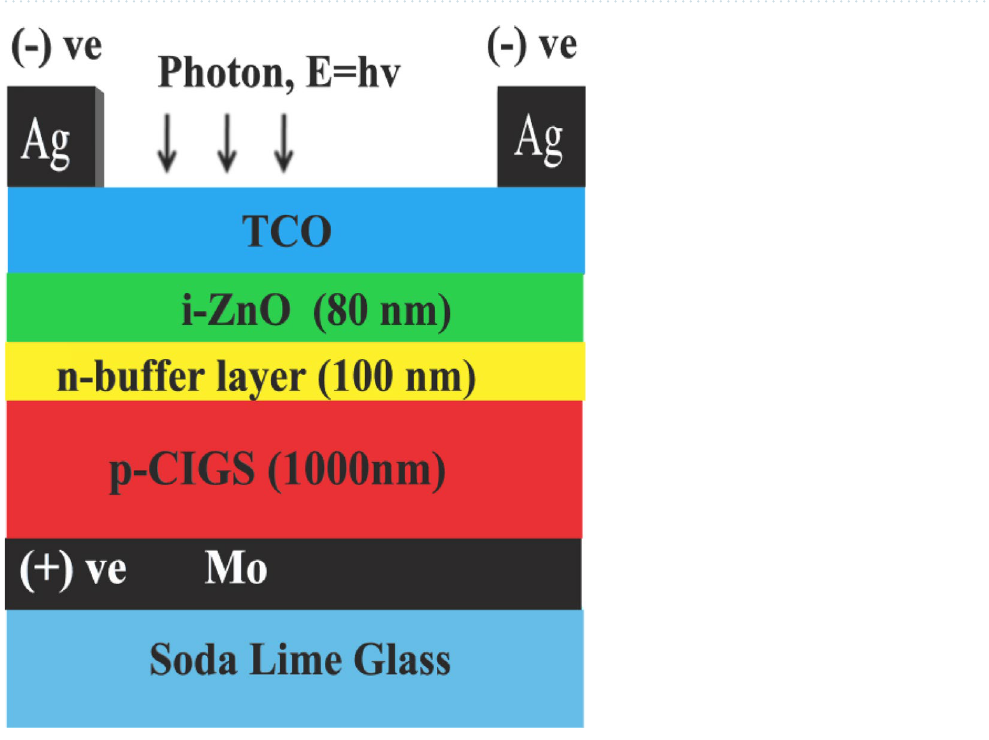
Figure 2. Device configuration for CIGS solar